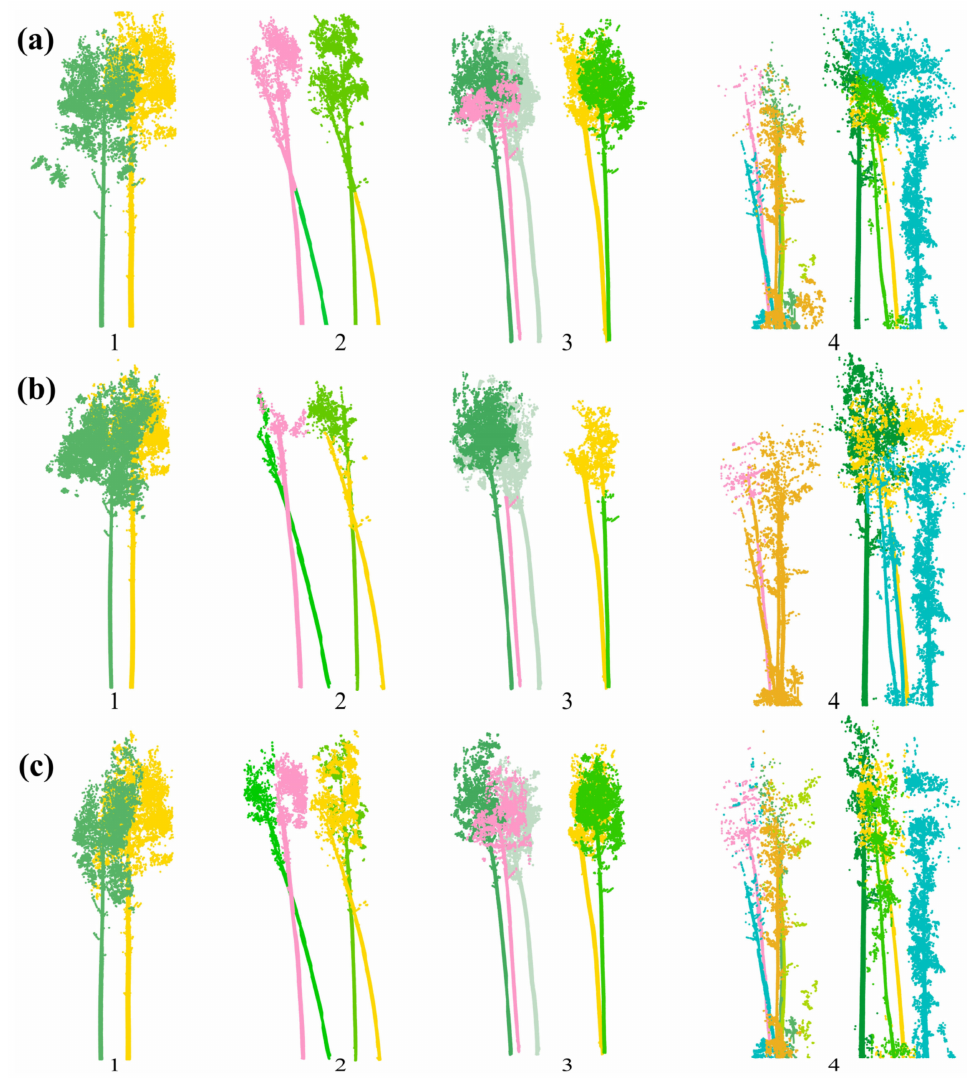
Figure 11. Segmentation results in the four typical scenes of Moso bamboos: ( a ) CSP; ( b ) GP; ( c )